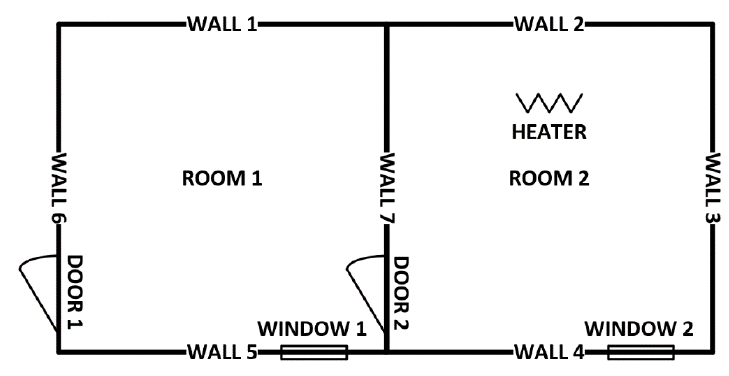
Figure 2. Layout of simple multi-zone building.